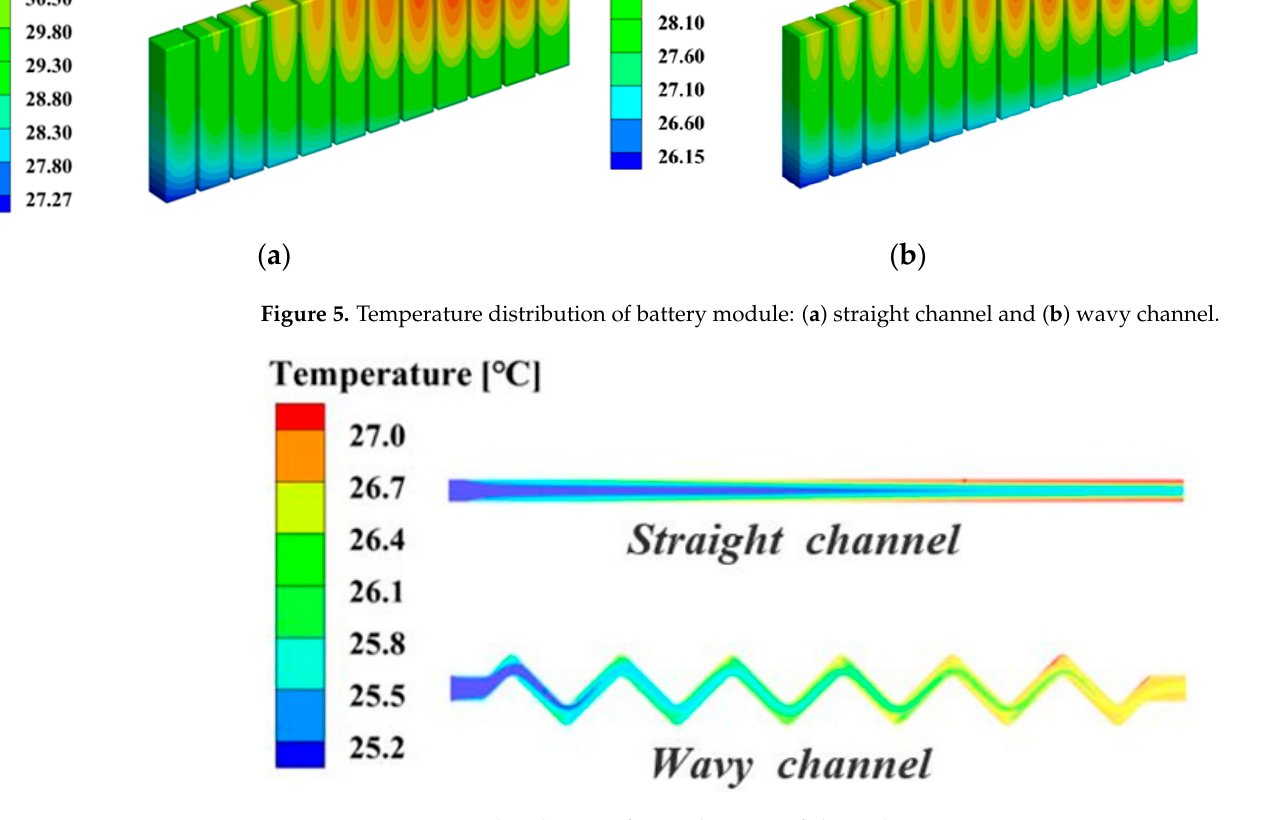
Figure 6. Temperature distribution of central section of channel.